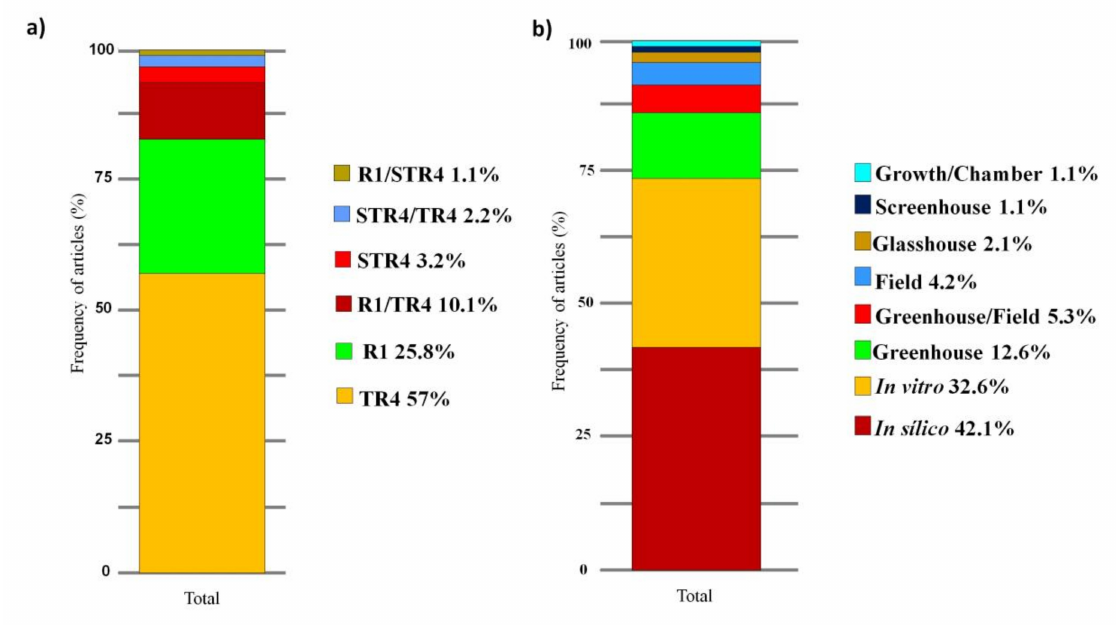
Figure 5. Stacked bar chart of the frequency of articles with different races of Fusarium oxysporum f. sp. cubense in the past ten years ( a ). Places of achievement of work in articles on the improvement of banana plants to Fusarium wilt carried out in the last 10 years ( b ). R1: race 1; STR4: subtropical race 4; TR4: tropical race